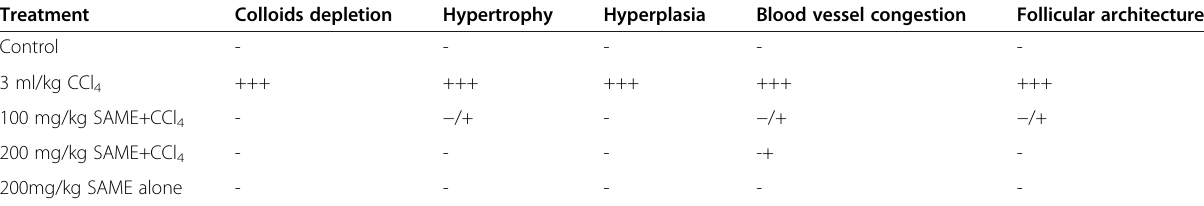
Table 6 Effect SAME on thyroid histopathology